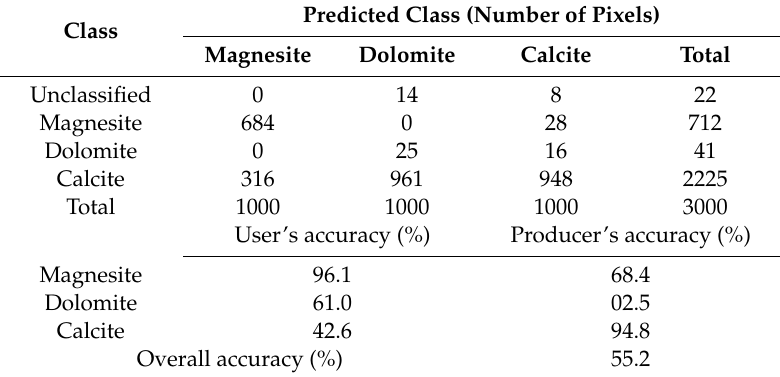
Figure 8. Box plots of the statistical indices for hyperspectral images transformed from the band ratios for carbonate minerals, talc, and other type classification ( a ), and the band ratios for magnesite, dolomite, and calcite classification ( b ). Table 6. A confusion matrix for the classification results of magnesite, dolomite, and calcite based on the band ratio